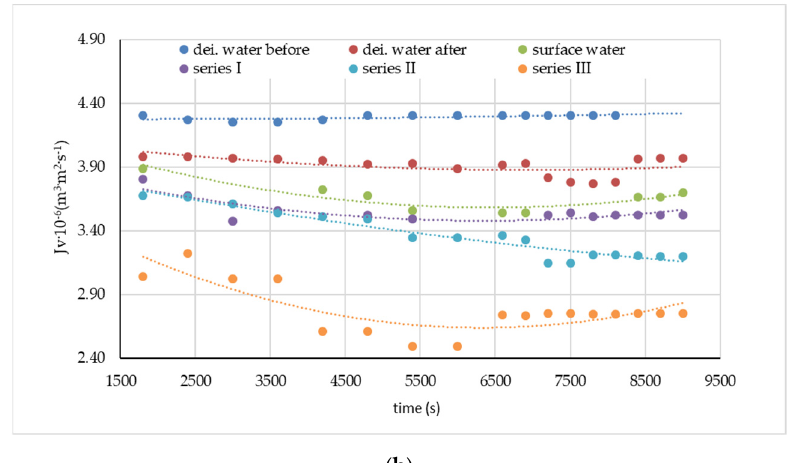
Figure 2. Change of the volumetric flux of the membrane permeate in the process of purifying surface water with BTEX: ( a ) pressure 1.0 MPa, ( b ) pressure 1.2 MPa, where: dei. water-deionized water, series I BTEX 0.802 mg dm –3 , series II BTEX 9.43 mg dm –3 , series III BTEX 15.76 mg dm –3